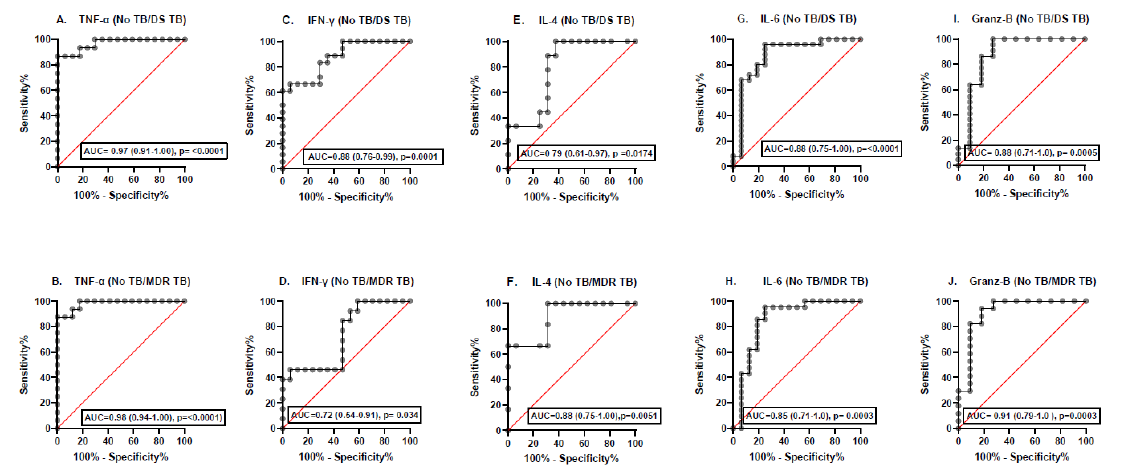
Figure 2. ROC curves ( A –J) showing the accuracies of individual serum cytokines in distinguishing between No-TB and MDR-TB or DS-TB.